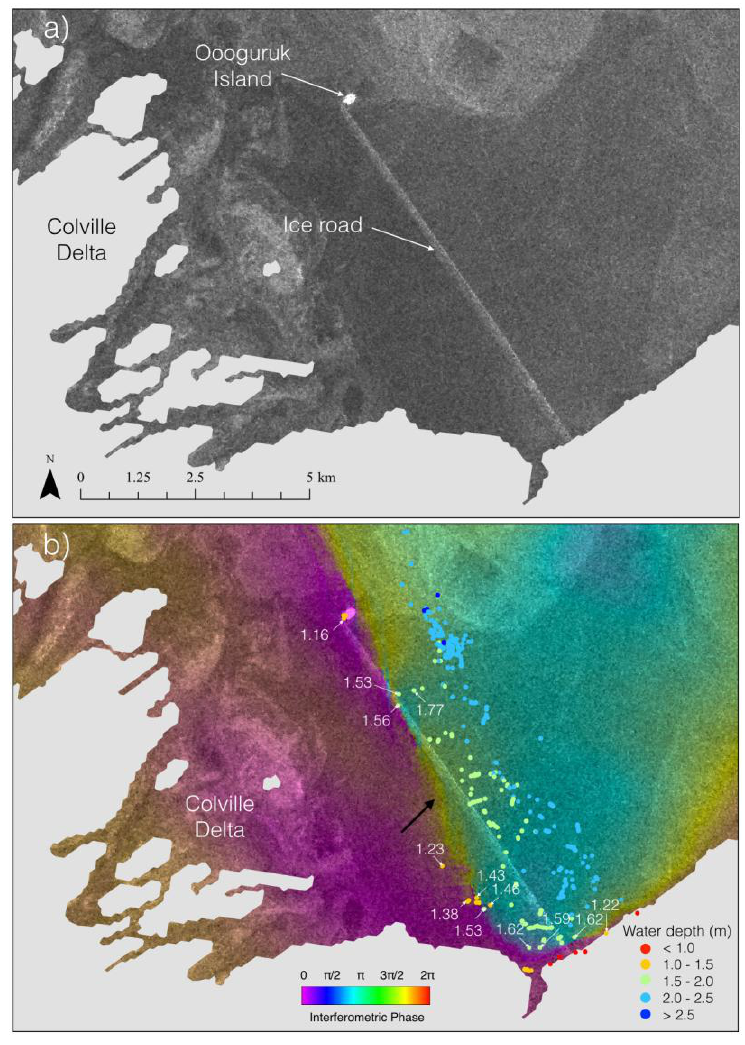
Figure 5. Sentinel-1 backscatter image over Colville River Delta 17 April 2017 ( a ) and superimposed interferometric phase values created using the following acquisition on 29 April 2017 ( b ). Bathymetric survey points based on survey data from 2005 to 2006. Estimated ice draft on 17 April based on surface air temperatures recorded in Deadhorse, Alaska, is ~1.35 m.